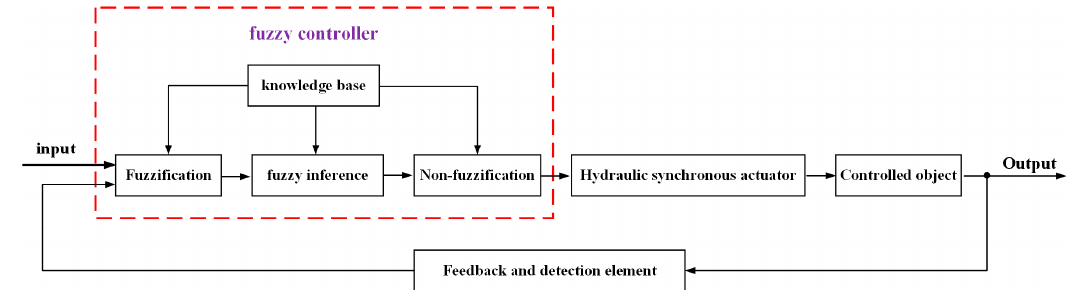
Figure 9. Fuzzy control block diagram of hydraulic synchronization control system.